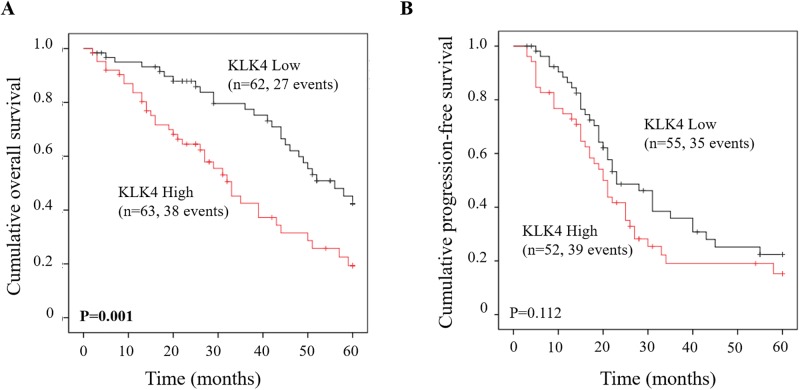
Probability of PFS and OS of patients with advanced high-grade serous ovarian cancer (FIGO III/IV) as stratified by KLK4 mRNA expression levels in primary tumor tissues.Patients with high KLK4 mRNA expression levels display a significantly worse OS rate (Kaplan-Meier analysis, p = 0.001) (A) but not PFS (B), compared to patients with low KLK4 mRNA expression levels.